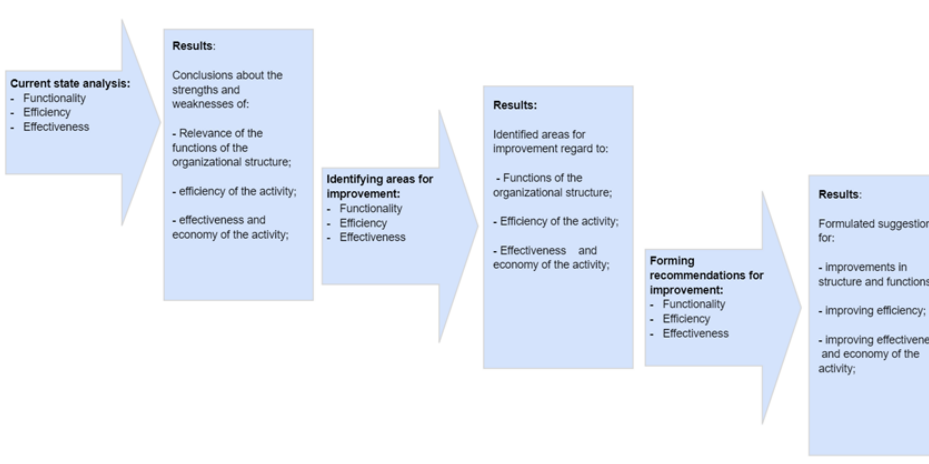
Figure 3: Stage 2 Activities